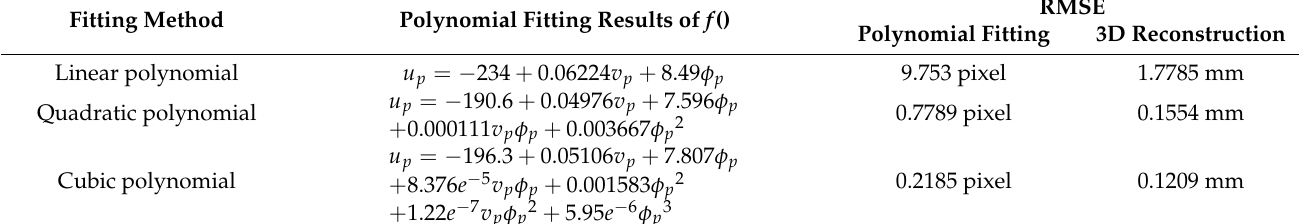
Figure 4. The 3D reconstruction of a checkerboard: ( a ) by using linear polynomial fitting method, ( b ) by using quadratic polynomial fitting method, and ( c ) by using cubic polynomial fitting method. Table 1. Polynomial fitting results with different fitting methods.